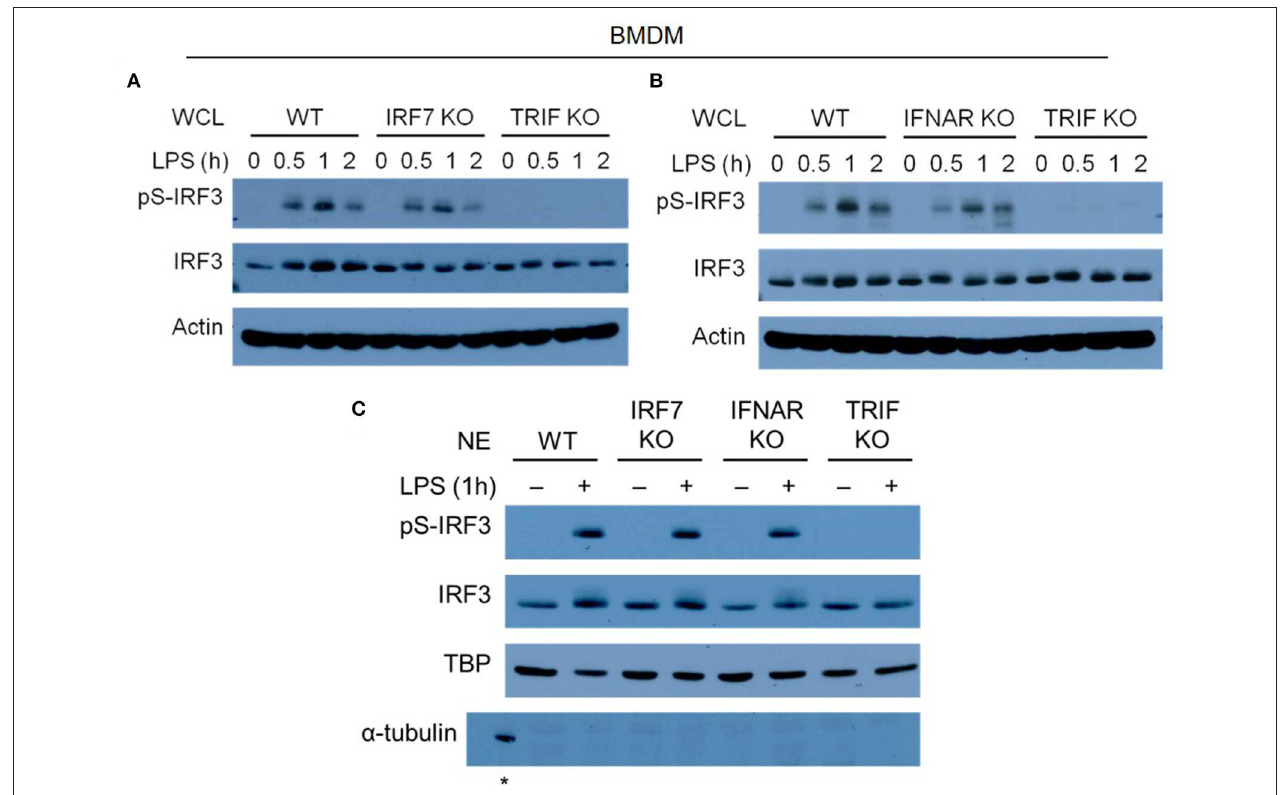
FIGURE 6 | IRF-7 and autocrine/paracrine IFNAR signaling regulate IFN- β expression independent of IRF-3 phosphorylation in LPS-challenged macrophages. (A,B) Western immunoblot analysis of phospho-IRF-3 and total IRF-3 protein expression in whole cell lysates (WCL) of IRF-7 knockout (A) or IFNAR1 knockout (B) BMDMs, compared to wild-type (WT) and TRIF knockout BMDMs, stimulated or not with 100ng/ml LPS for 0–2h. Data are representative of at least three independent experiments. Actin was used as a loading control. (C) Western immunoblot analysis of phospho-IRF-3 and total IRF-3 protein expression in nuclear extracts (NE) of wild-type (WT), IRF-7 knockout, IFNAR1 knockout, and TRIF knockout BMDMs, stimulated or not with 100ng/ml LPS for 0–2h. Data are representative of at least two independent experiments. Actin and TATA-binding protein (TBP) were used as loading controls. *indicates α -tubulin detected in WCL of un-stimulated WT BMDMs as a